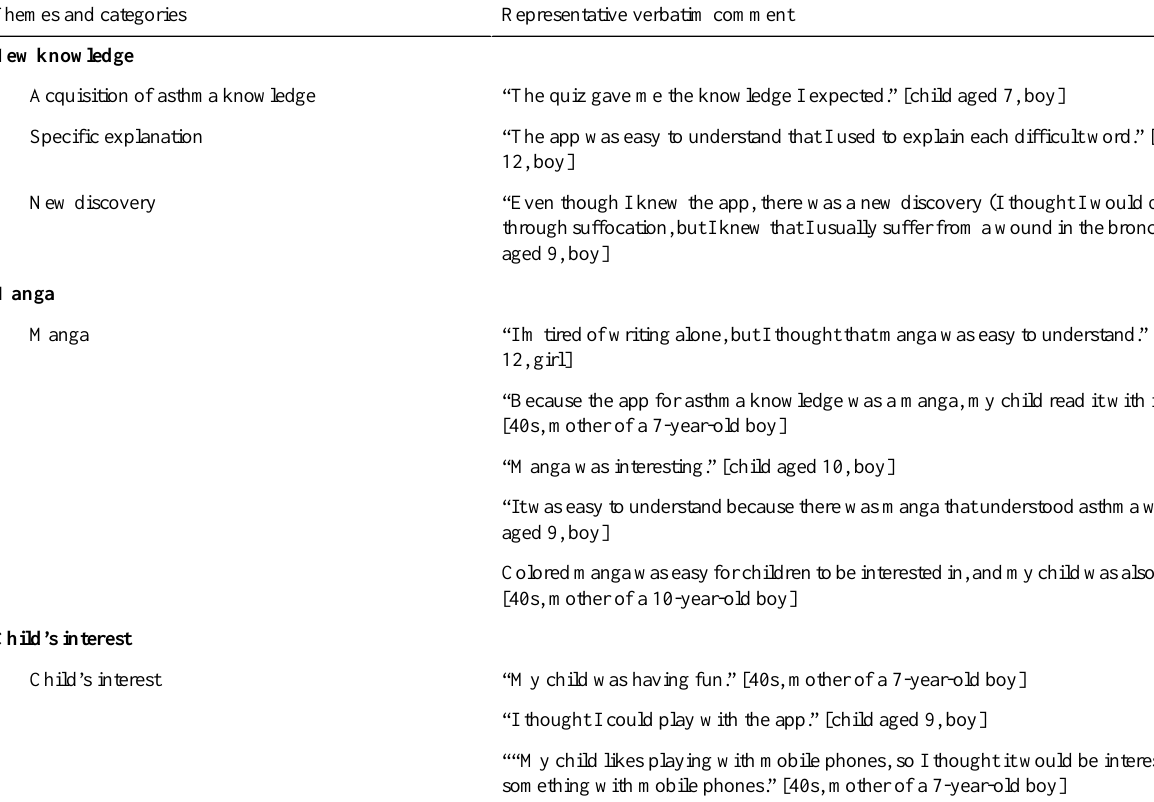
Table 3. Good aspects for 7- to 12-year-old children and caregivers.